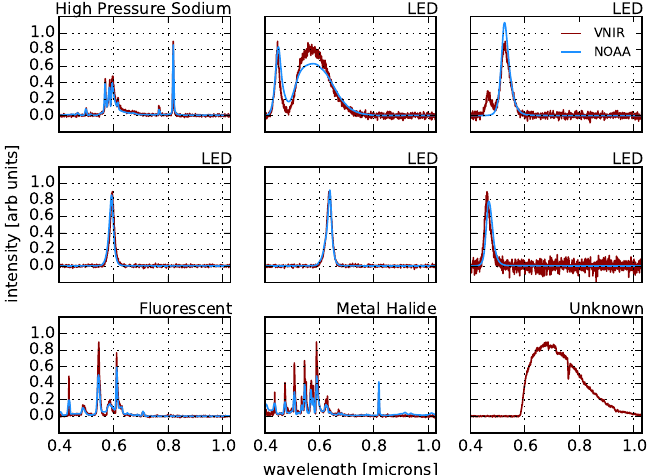
Figure 12. Several examples of high S/N spectra in our sample that are correlated with the NOAA templates shown in Figure 9. The bottom right spectrum is an example of a lighting technology that is not represented in the lab